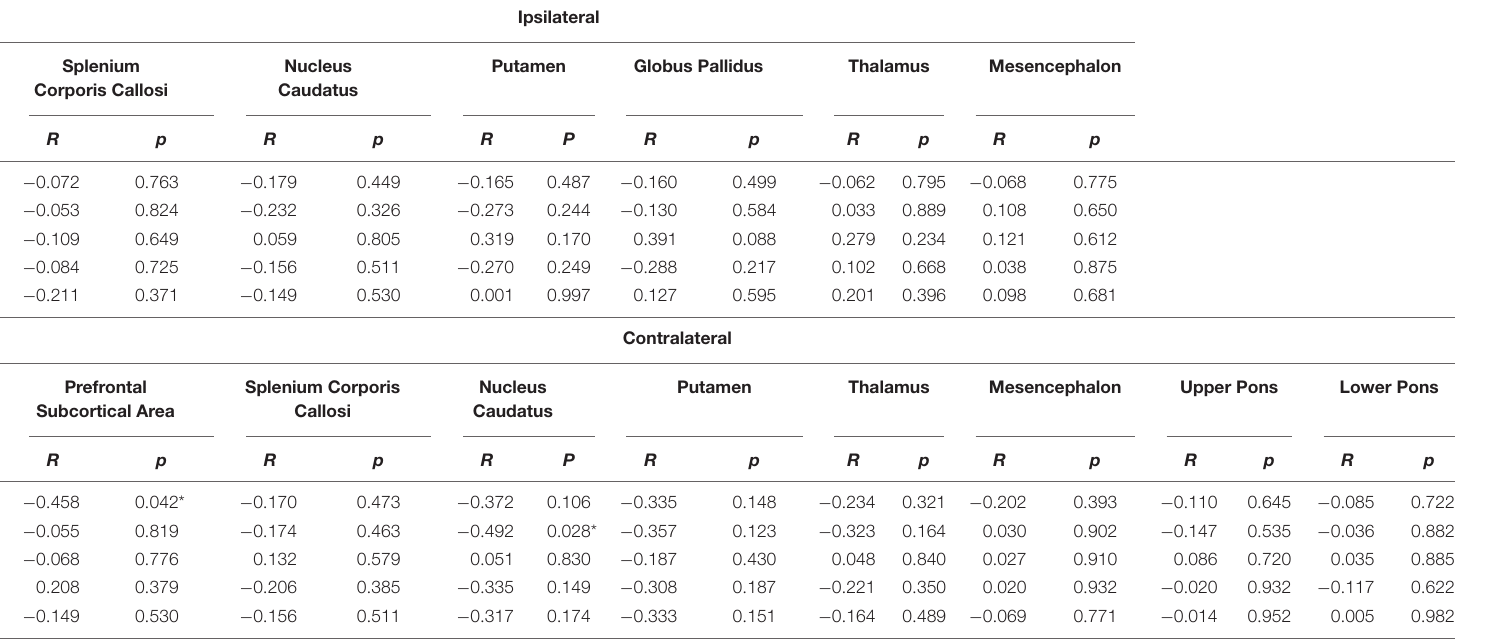
TABLE 6 | Correlations of MDS-UPDRS to significant changes of relative proton density in respect to the most affected body side of the patients estimated by Spearman’s correlation test 1 . Clinical